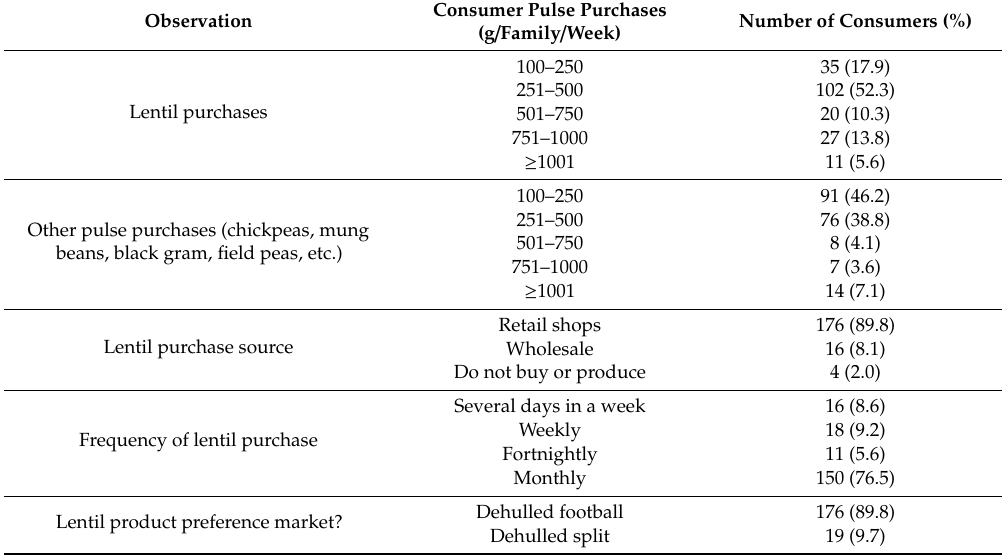
Table 2. Consumer habits and patterns of lentil